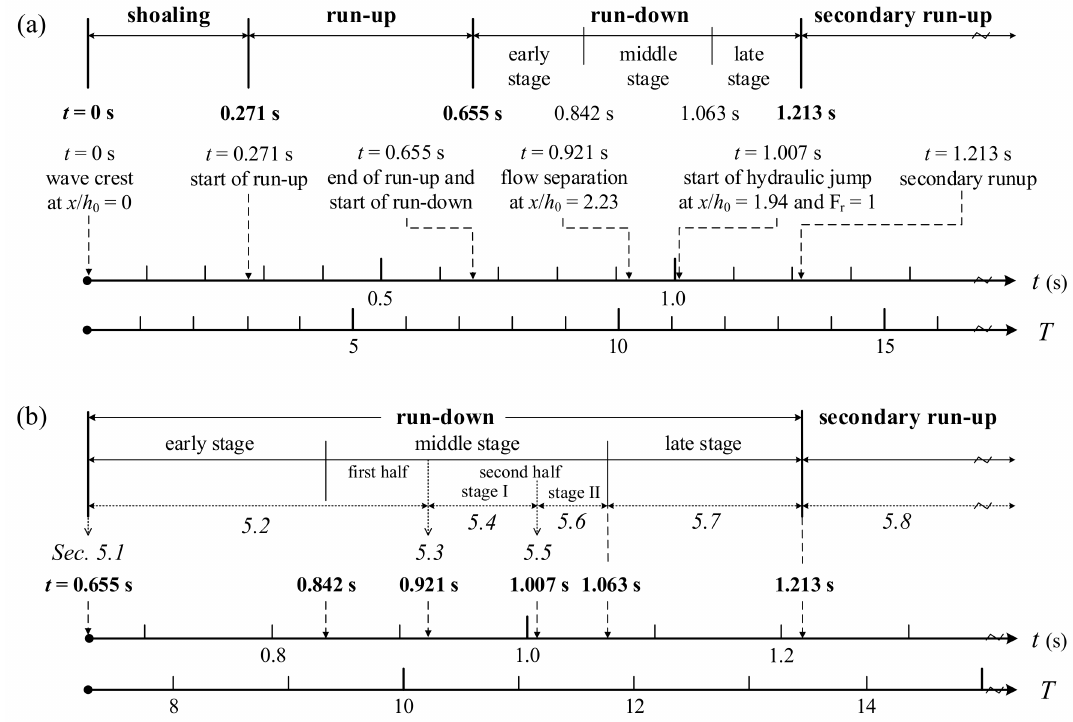
Figure 6. Chronological sketches for ( a ) complete evolution of run-up and run-down process; and ( b ) detailed classification for different stages of run-down process (Case